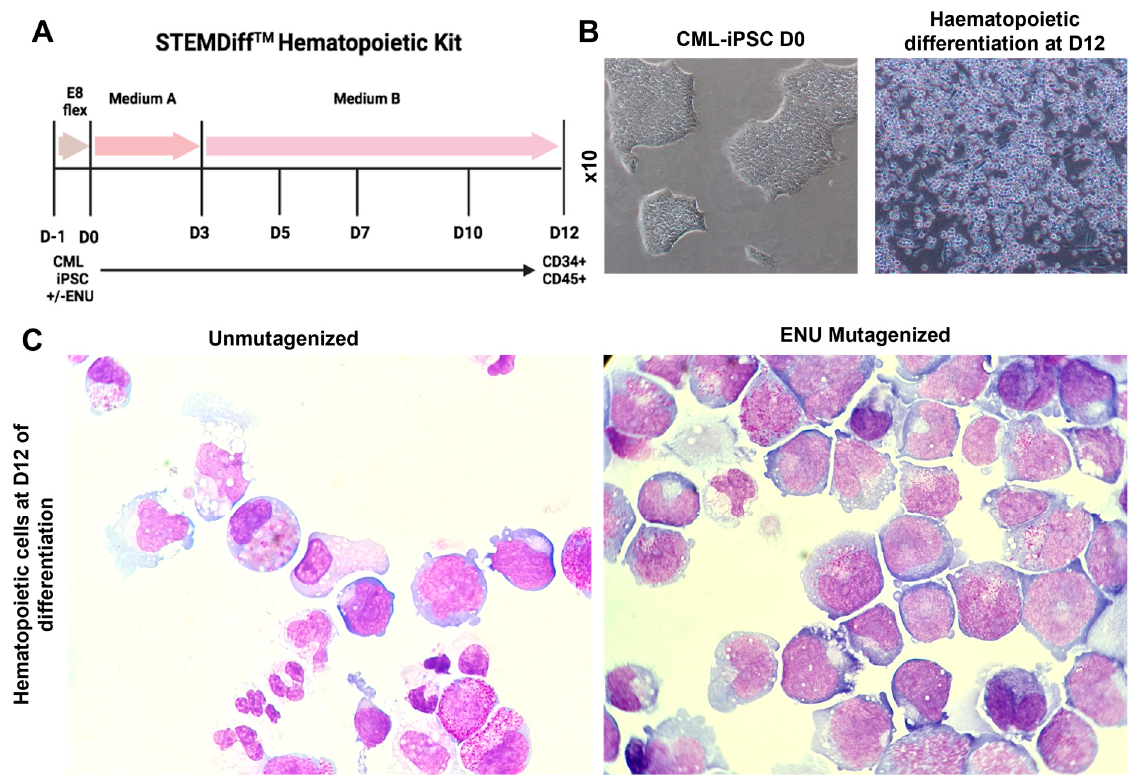
Figure 2. Hematopoietic differentiation of mutagenized and unmutagenized CML-iPSC. ( A ) Hematopoietic differentiation protocol of mutagenized and unmutagenized CML-iPSCs. During the first three days, the generation of mesoderm was followed by hematopoietic induction from D3 to D12. ( B ) Morphology of CML-iPSCs at their pluripotent stage (left) and at D12 of differentiation (right). ( C ) Microscope pictures (magnification x60) of May–Grünwald and Giemsa staining at day 12 of floating hematopoietic cells differentiated from unmutagenized CML-iPSC (left) and mutagenized CML-iPSC (right).